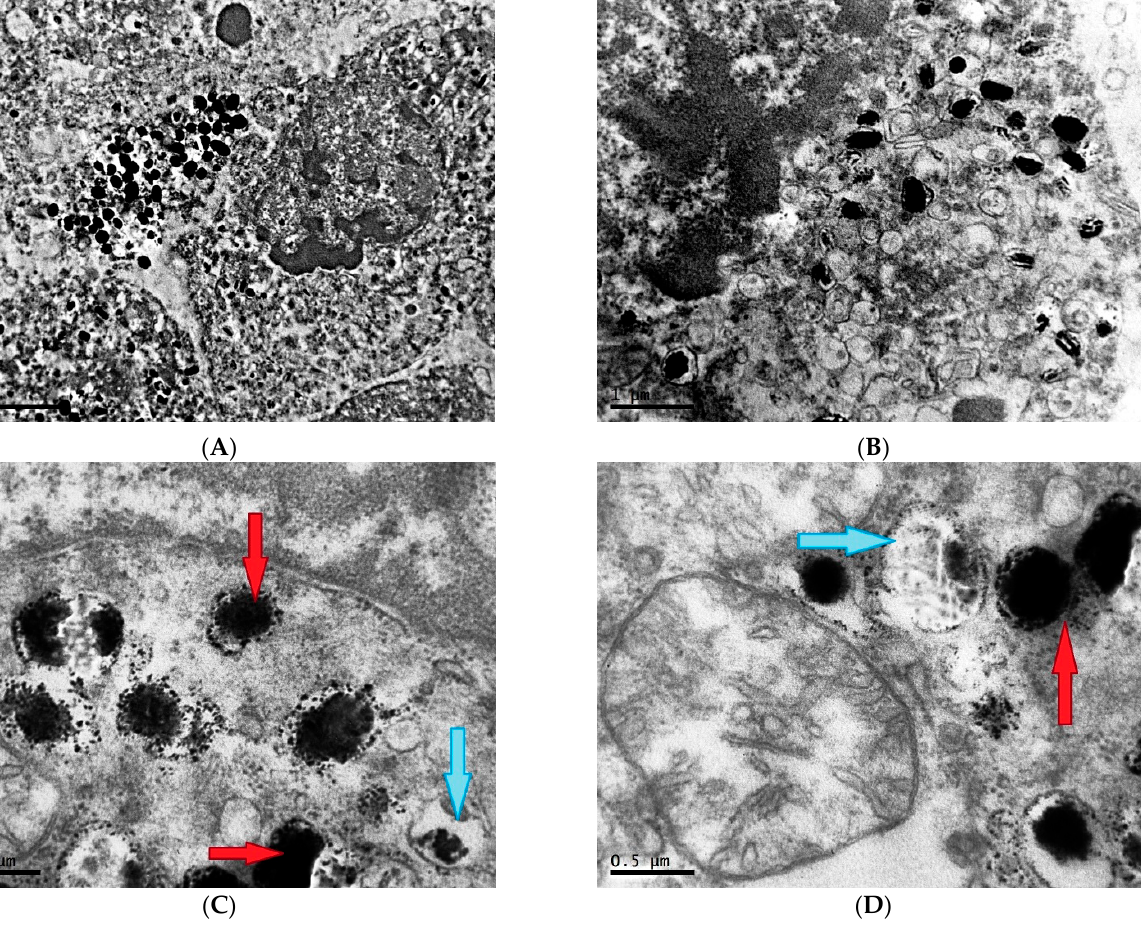
Figure 3. Melanosomes and mitochondria of cells of transplantable malignant melanoma B16 under the influence of fixed light regime. Blue arrows—premelanosomes, red arrows—mature melanosomes. TEM, ( A )—×8000, ( B )—×20,000, ( C , D )—×40,000.